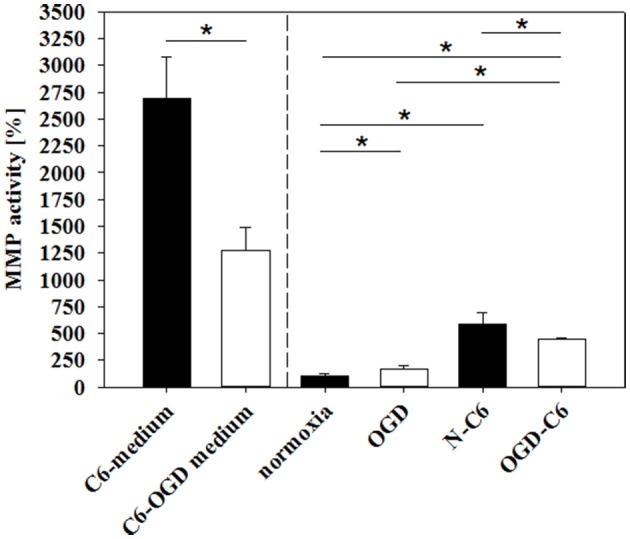
Influence of 4 h oxygen/glucose deprivation (OGD) treatment and presence of astrocyte soluble factors on total MMP activity in medium supernatants. C6-medium, supernatants of C6 cells after 4 h normoxia; C6-OGD medium, supernatants of C6 cells after 4 h OGD; normoxia, supernatants of cerebEND cells after 4 h normoxia; OGD, supernatants of cerebEND cells after 4 h OGD; N-C6, supernatants of cerebEND cells after 4 h normoxia treated with C6-medium; OGD-C6, supernatants of cerebEND cells after 4 h OGD treated with C6-OGD medium. Statistical significance was labeled with *(p < 0.05, two-sided student's t-test with same variances). Data are presented as means ± s.e.m. (n = 8–19).